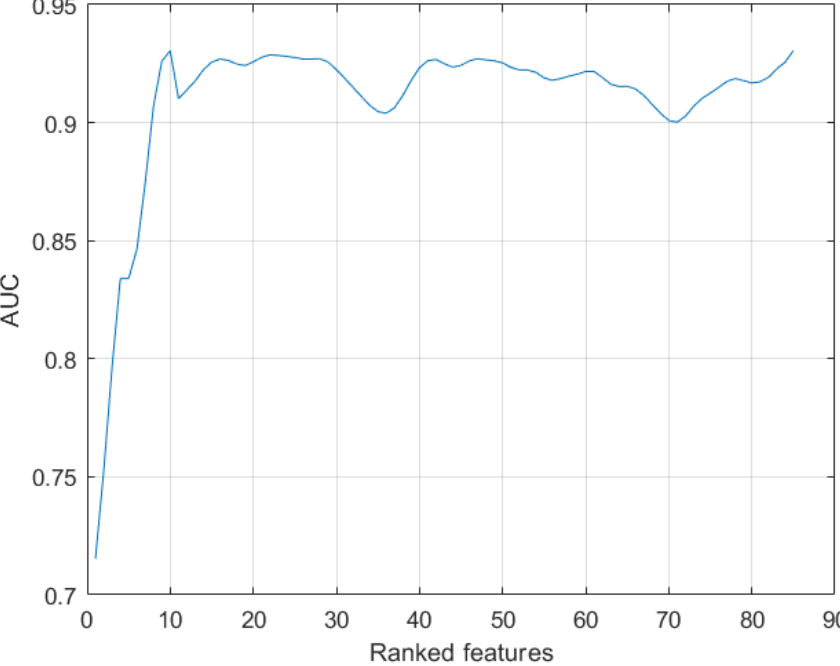
Figure 3. AUC values resulted from incremental ranked features of the RF model.